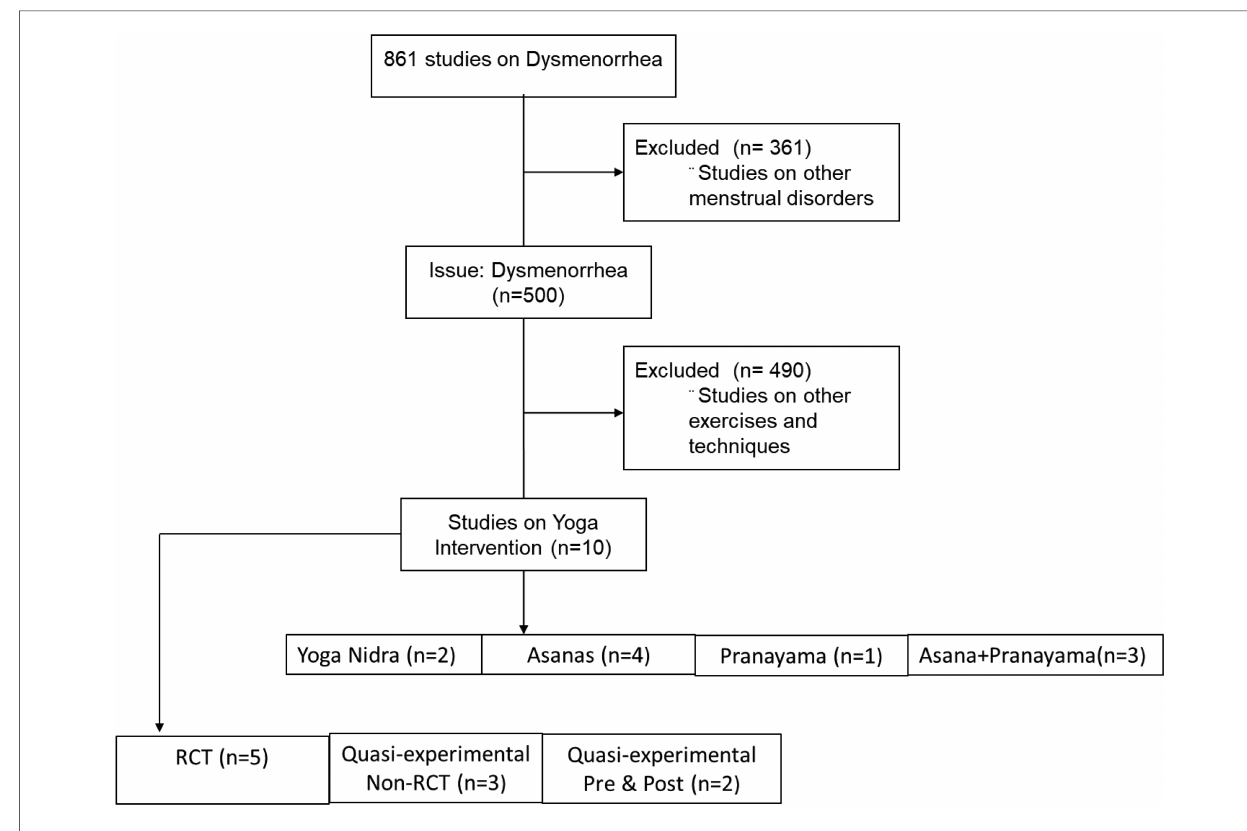
FIGURE 2 Flow diagram of research studies on